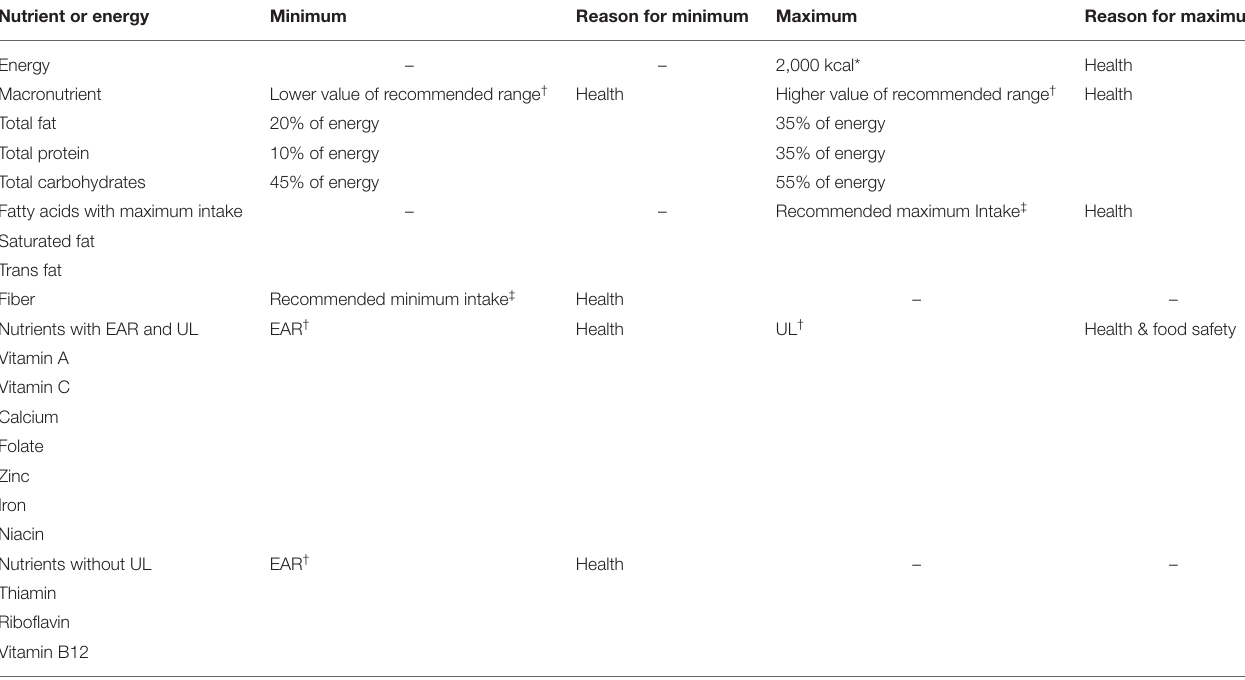
* Based on 2013 Lebanese Food Based Dietary guidelines. † IOM for adults, dietary reference intakes for energy, carbohydrate, fiber, fat, fatty acids, cholesterol, protein, and amino acids (2002). ‡ World Health Organization Recommendations, World Health Organization (20). Healthy diet (No. WHO-EM/NUT/282/E). World Health Organization. Regional Office for the Eastern